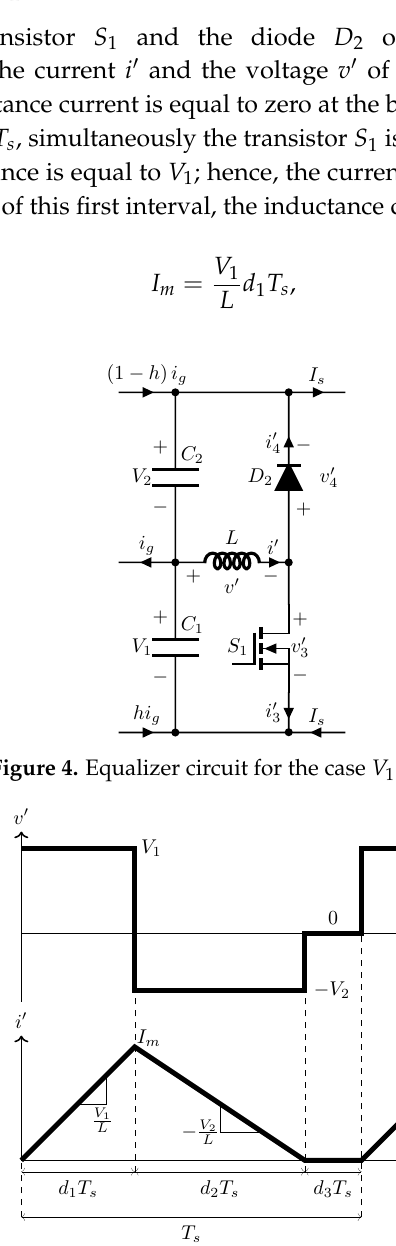
Figure 5. Waveforms of v (cid:48) and i (cid:48) associated with the equalizer circuit for the case V 1 > V 2